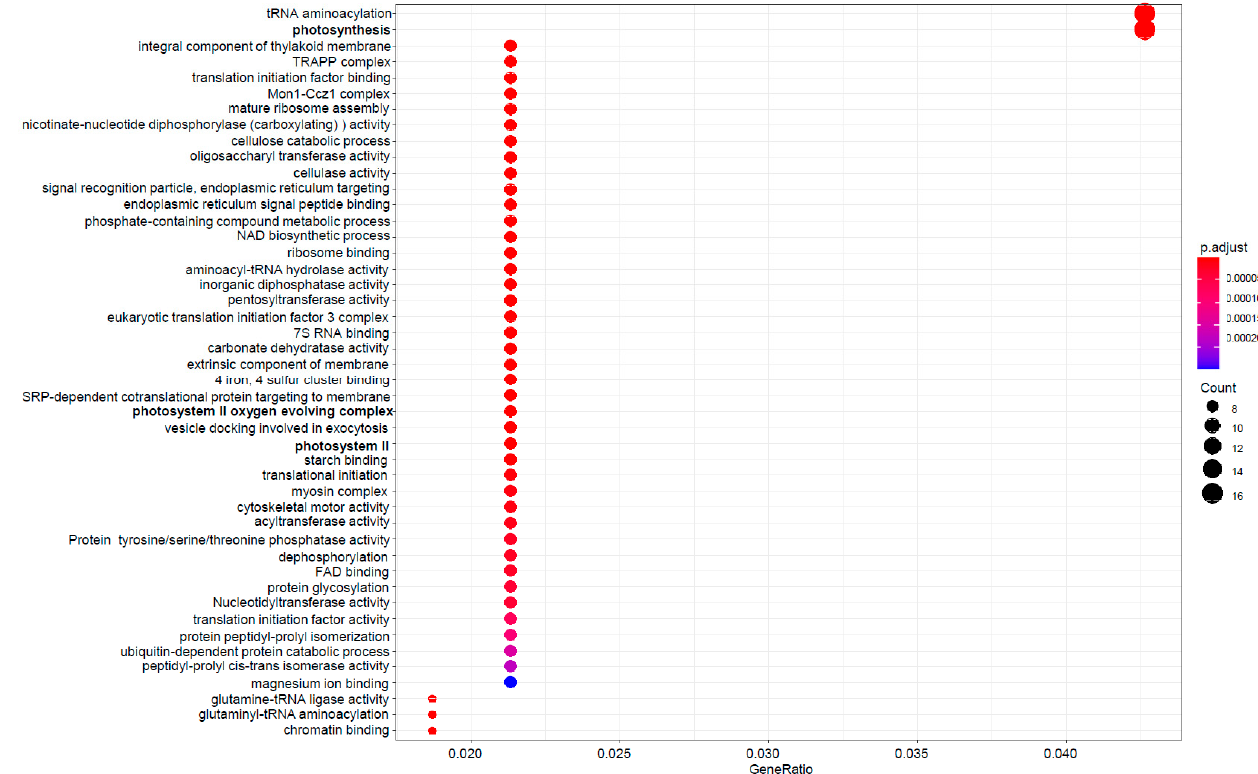
Figure 3. Dot plot showing the enrichment of the 92 putative fast-evolving genes. The dot sizes represent the numbers of genes. represent the numbers of